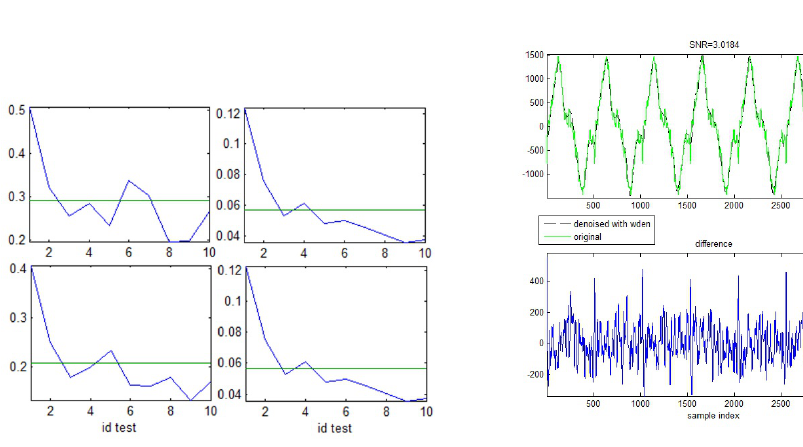
Figure 7. Steady case, most significant noise. Top - original signal and signal denoised with wden. Bottom – di ff erence between original sig- nal and signal denoised with